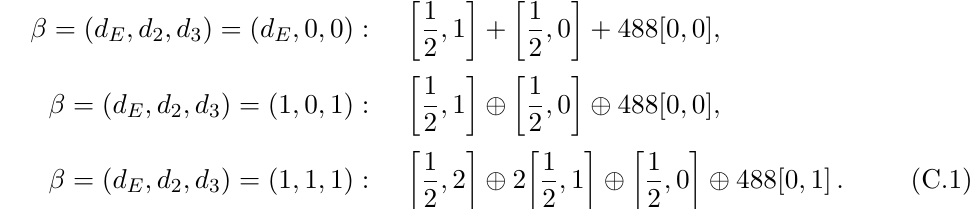
for the homology class β = ( d β g L \ g R